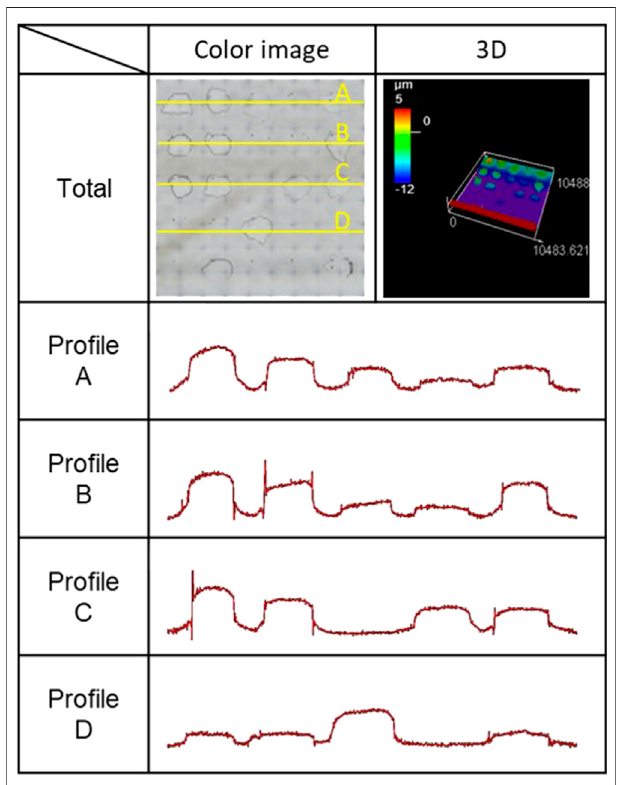
FIGURE 7 | 3D map, color image, and pro fi le of the glass surface when the mask tape peeling off during repeated MSJ treatment.